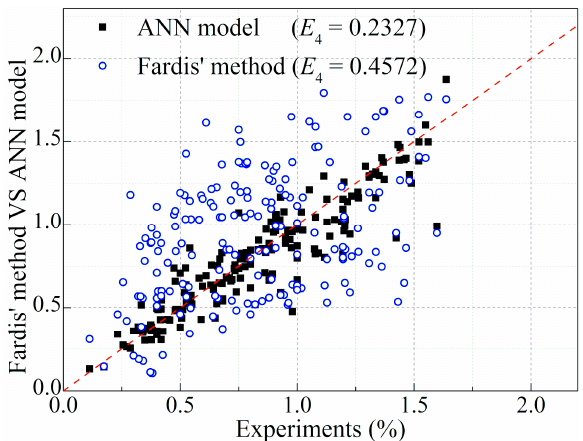
Figure 12. Comparison results of the yield drift between the experimental, ANN model and Fardis’ method [40].